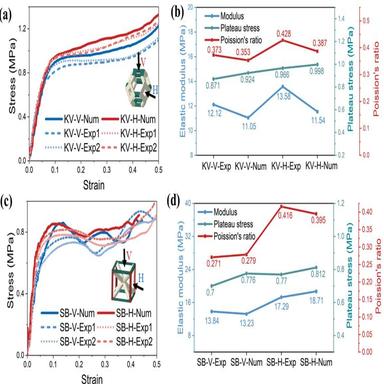
Comparisons of the numerical and experimental mechanical responses along vertical and horizontal direction: (a) stress-strain curves of KV lattice; (a) elastic modulus, plateau strength, and Poisson's ratio of KV lattice; (c) stress-strain curves of SB lattice; and (d) elastic modulus, plateau strength, and Poisson's ratio of SB lattice.